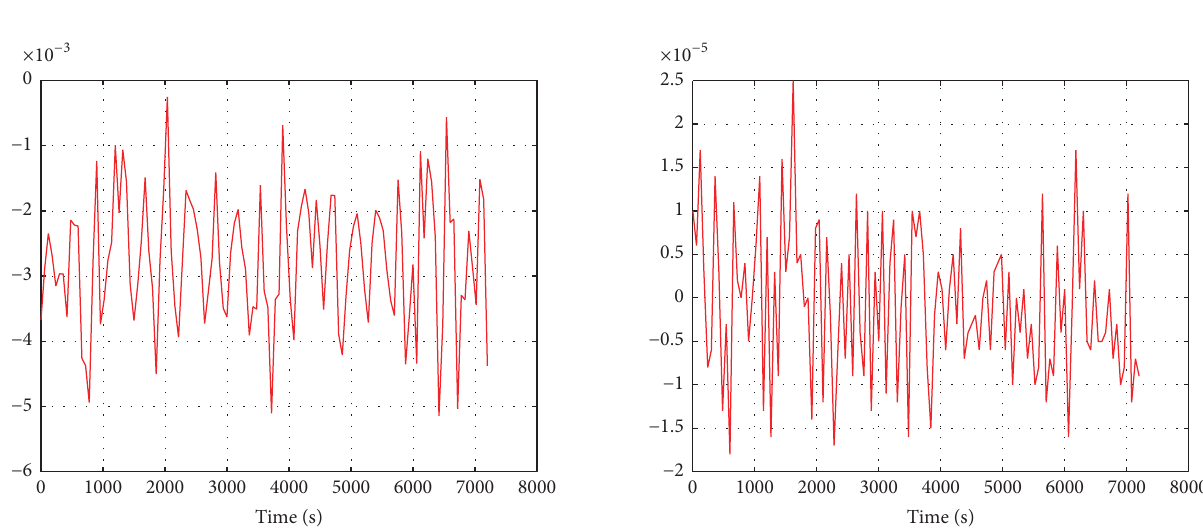
Figure 7: The variation of coverage rate difference when division granularity is 5 ∘ .